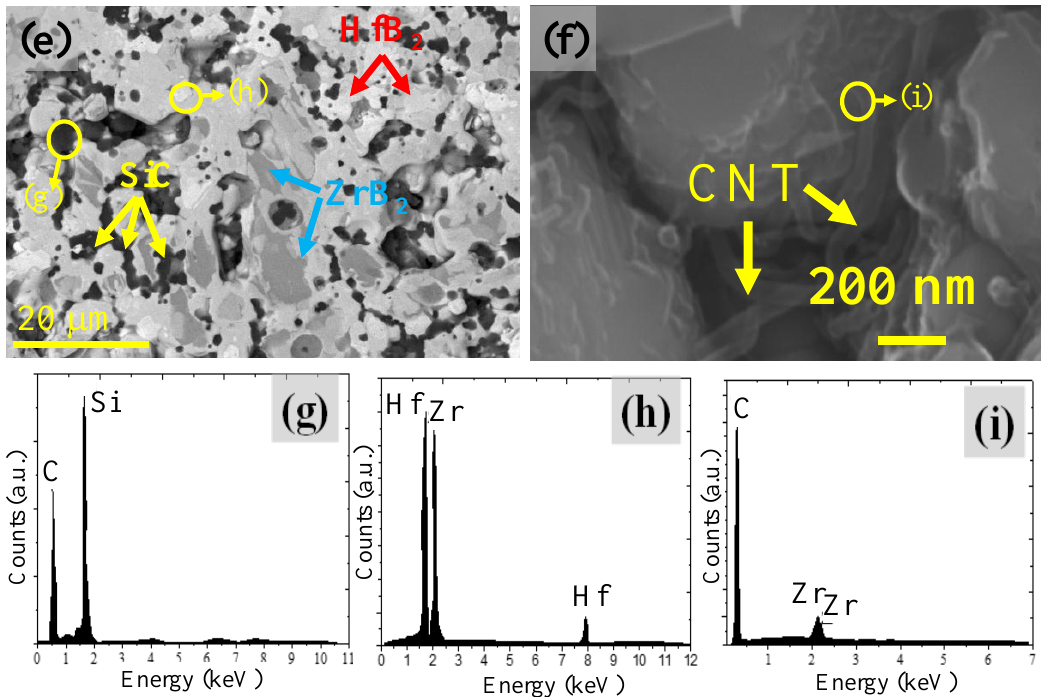
Figure 5. Back scattered SEM images of the SPS processed HfB 2 -ZrB 2 -SiC-CNT composites: ( a ) H20S and inset shows that SiC sits at the intragranular regions, ( b ) Z20S, ( c ) HZ20S, ( d ) HZ20S6C, high magnification image ( e ) eliciting mutual diffusion of HfB 2 and ZrB 2 of the marked area in ( c ) and ( f ) marked area in ( d ) showing the presence and morphology of the CNT remains intact even after SPS processing. EDS of the marked region confirming presence of ( g ) SiC, ( h ) solid solution of HfB 2 and ZrB 2 ; and ( i ) CNT.